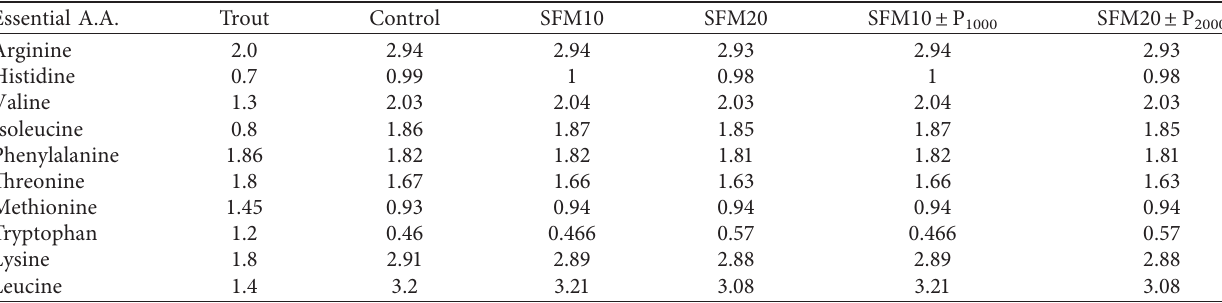
Table 2: Essential amino acid composition of experiment feeds.